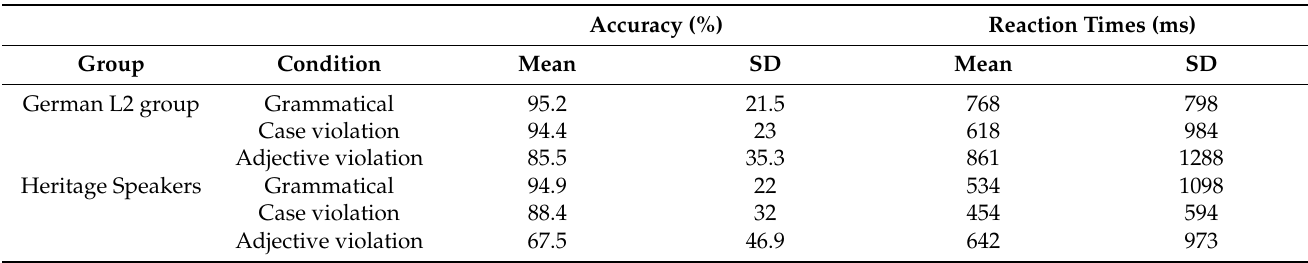
Table 3. Mean accuracy (%) and reaction times (ms) with standard deviations for the three analyzed conditions in both